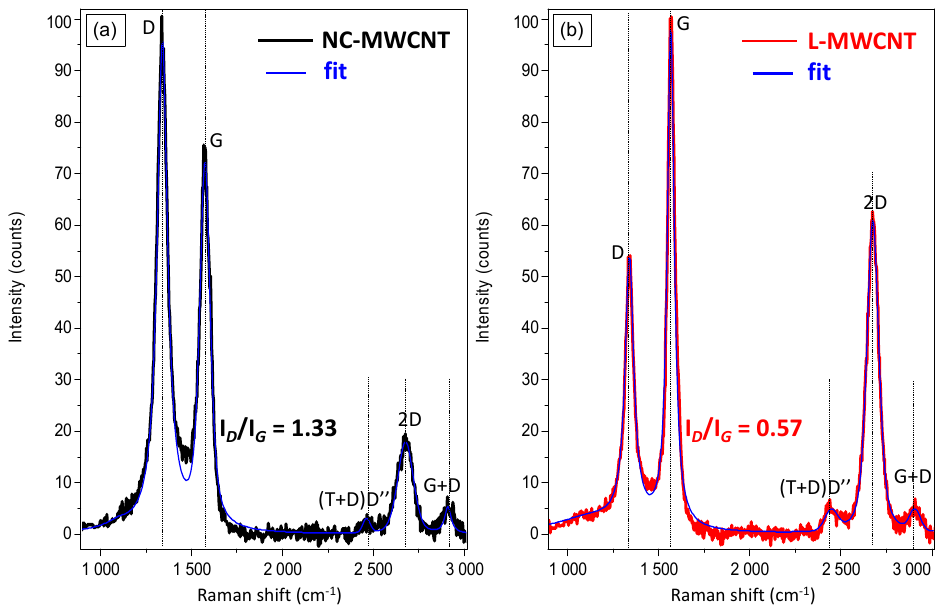
Figure 2. Raman spectra of ( a ) NC-MWCNT and ( b ) L-MWCNT showing characteristic bands of MWCNT material with different graphitization degree and number of defects of the CNT graphitic lattice.